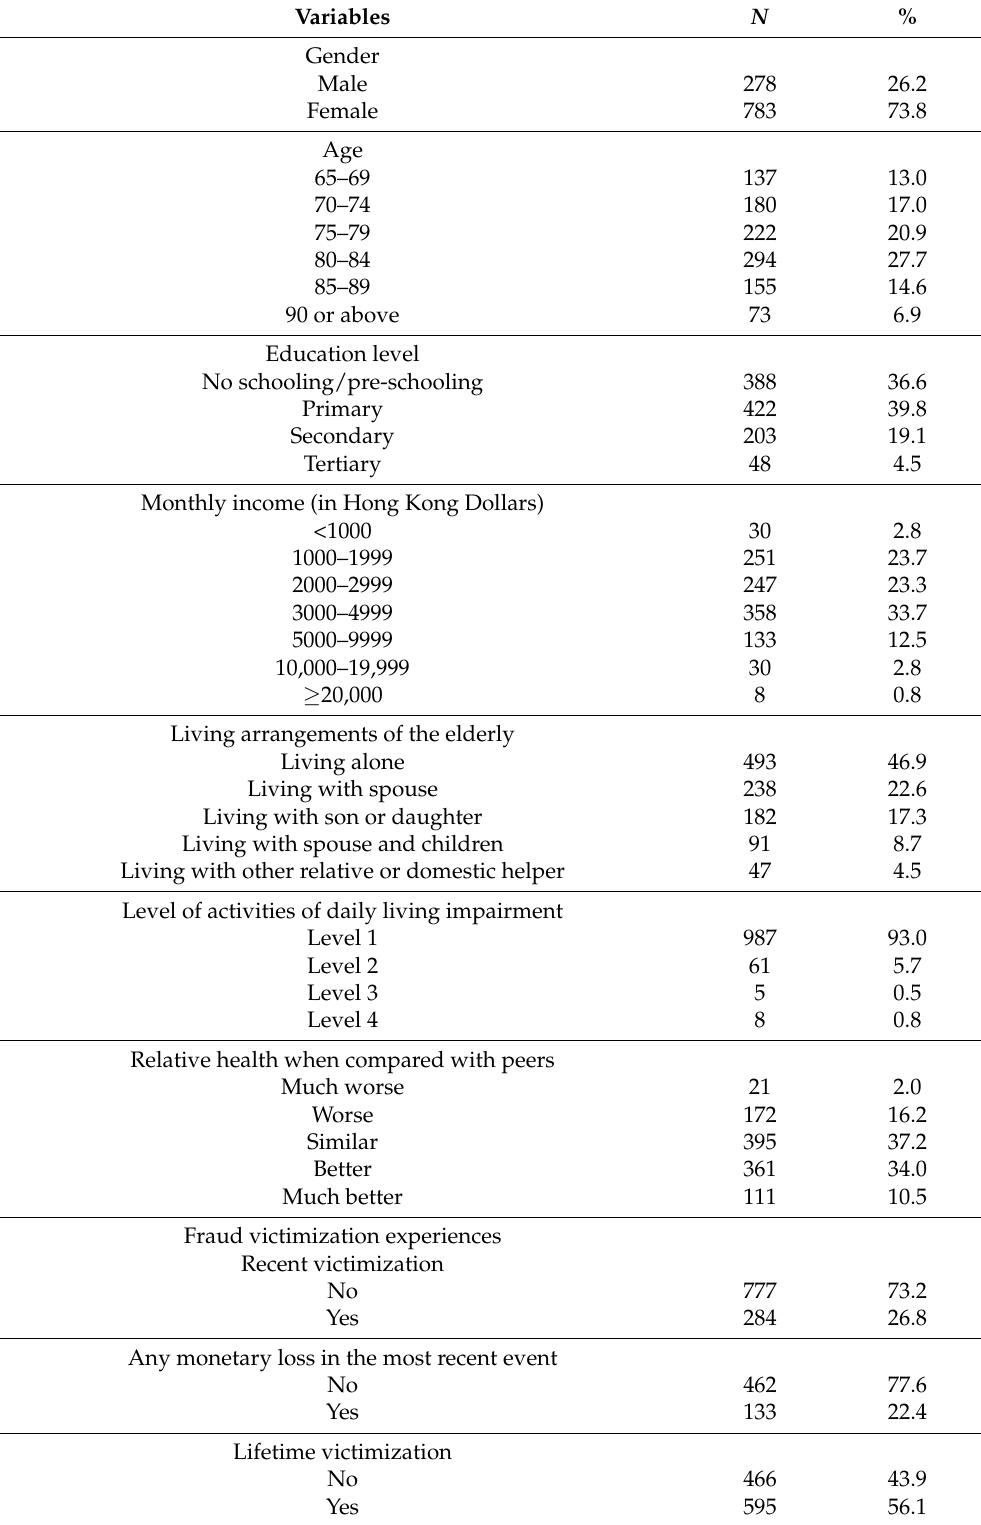
Table 1. Descriptive statistics ( N =